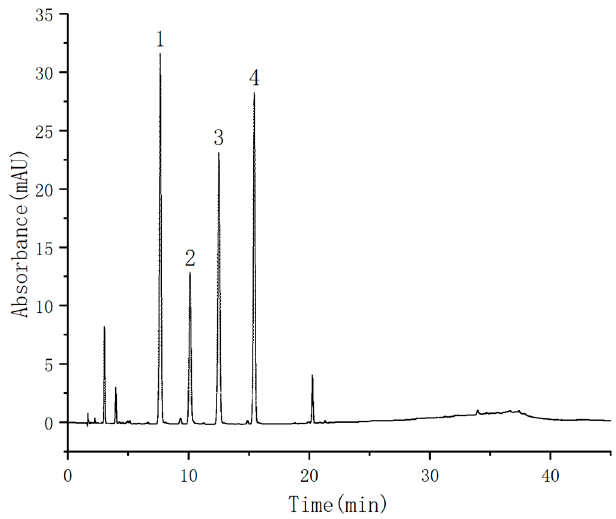
Figure 15. Chromatograms of four sulfonamides: (1) sulfamethyldiazine; (2) sulfamethazine; (3) sulfamethoxypyridazine; and (4) sulfamethoxazole.